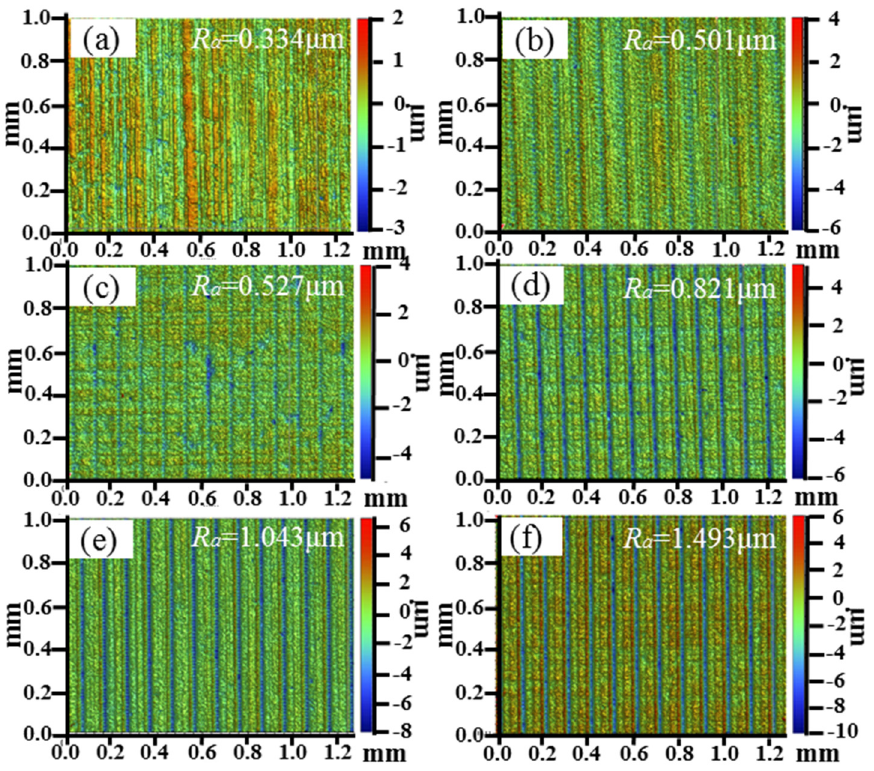
Figure 4. Surface roughness of the samples: ( a ) P-0, ( b ) P-1, ( c ) P-2, ( d ) P-3, ( e ) P-4, ( f )